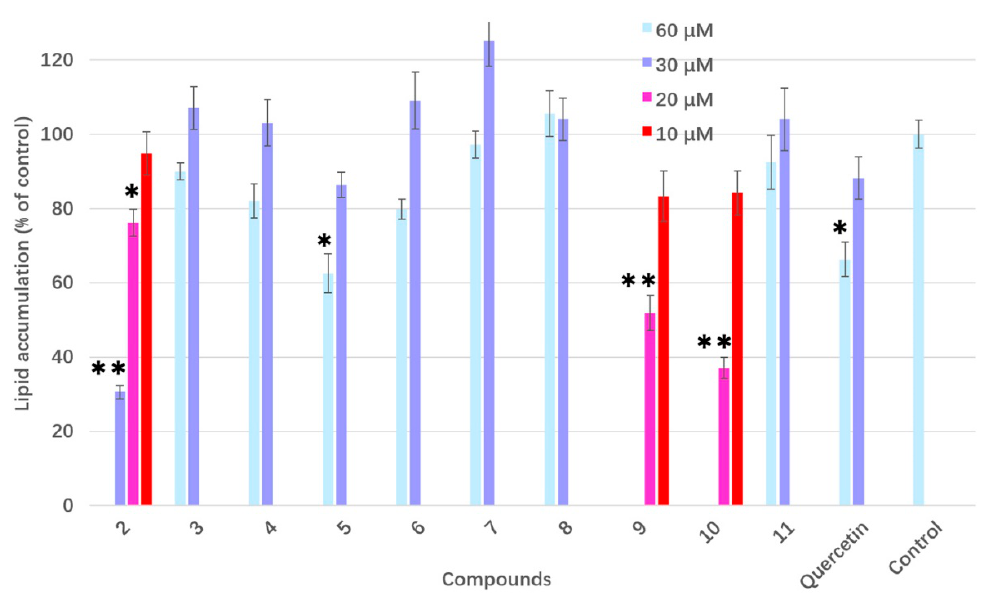
Figure 6. Effects of each ITC on lipid accumulation (* p < 0.05 vs. control, ** p < 0.01 vs. control). Higher concentrations of compounds 2 , 9 , and 10 showed a significant cytotoxicity. Quercetin was served as a positive control. Data are expressed as mean ± SD ( n = 3).